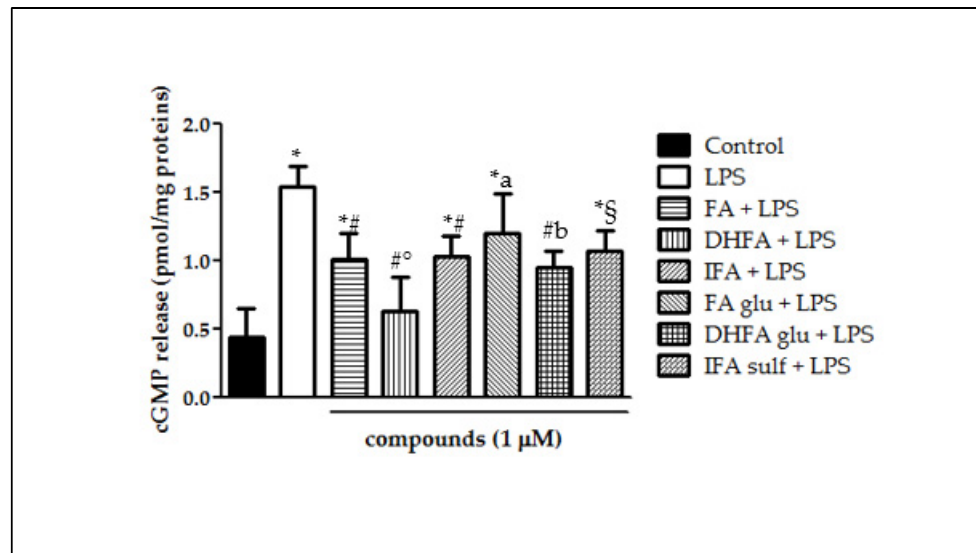
Figure 5. cGMP release (pmol/mg proteins) in Caco ‐ 2 cells incubated for 48 h with LPS (1 μ g/mL) after pretreatment with FA, DHFA, IFA, FA glu, DHFA glu, and IFA sulf (1 μ M) ( n = 9). Control and LPS groups were pretreated with an equivalent volume of methanol. Significant differences among groups are described using different superscript symbols; * = significant